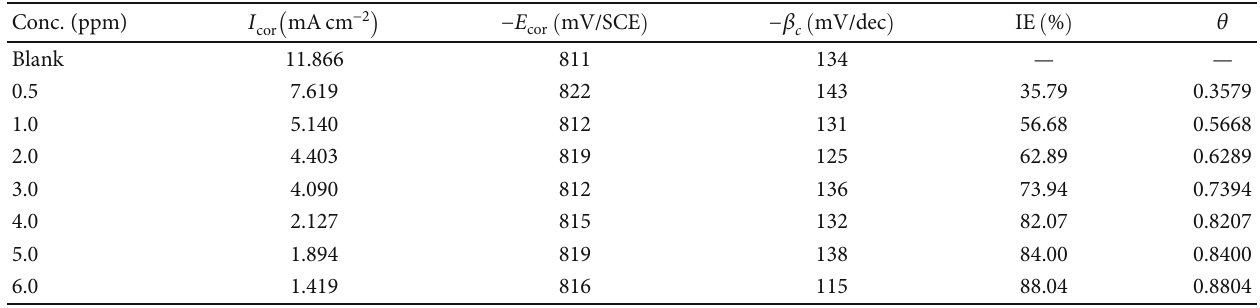
Table 3: Derived polarization electrochemical parameters of AA3003 alloy in 1 M HCl medium in the absence and presence of OMW at di ff erent concentrations (at 298 K).